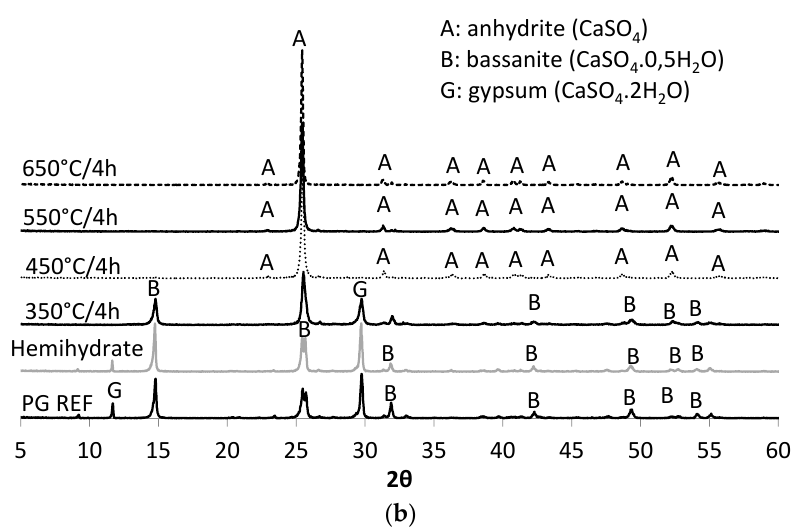
Figure 3. X-ray diffraction (XRD) diffractograms for phosphogypsum (PG REF), β -hemihydrate, and PAs. ( a ) calcined for 2 h ( b ) calcined for 4 h.